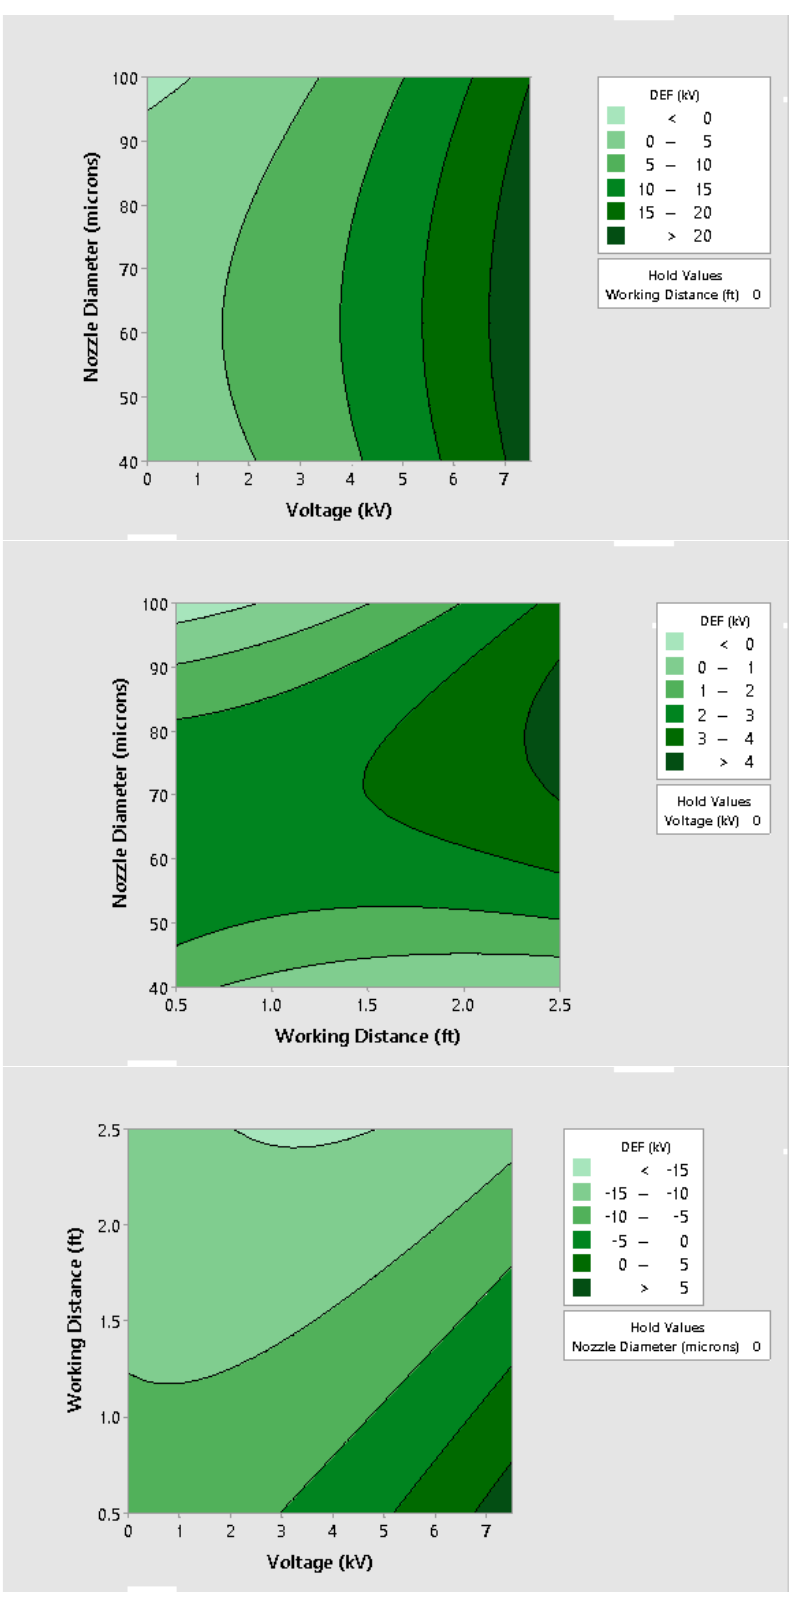
Figure A22. Teflon: quantitative representation of average differential electric field vs. working distance (feet), nozzle sprayer size ( µ m), and charge voltage